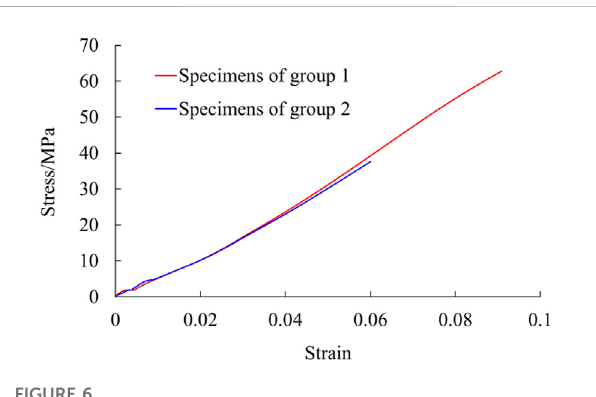
FIGURE 6 Stress – strain relationships of organic glass specimens.